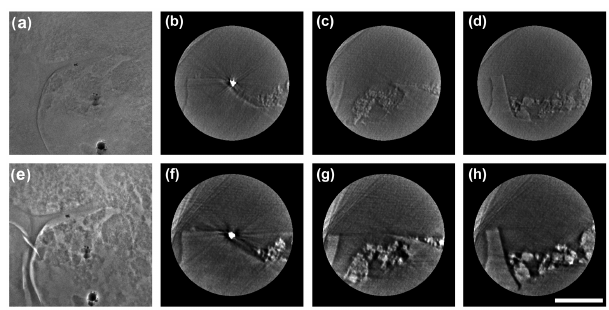
Figure 1. The 2-D X-ray images for BC and the mineral nanopar- ticle consortium. Two images are taken of the same region using absorption contrast mode (a) and phase contrast mode (e) , respec- tively. Cross-section views of the reconstructed 3-D tomography un- der each mode at different depths relative to the position of gold nanoparticle along the z axis as a reference. (b) and (f) are sections extracted at the position of the gold particle. (c) and (g) are sections extracted at 800nm above the gold particle. (d) and (h) are sections extracted at 800nm below the gold particle. The scale bar is 5µm.